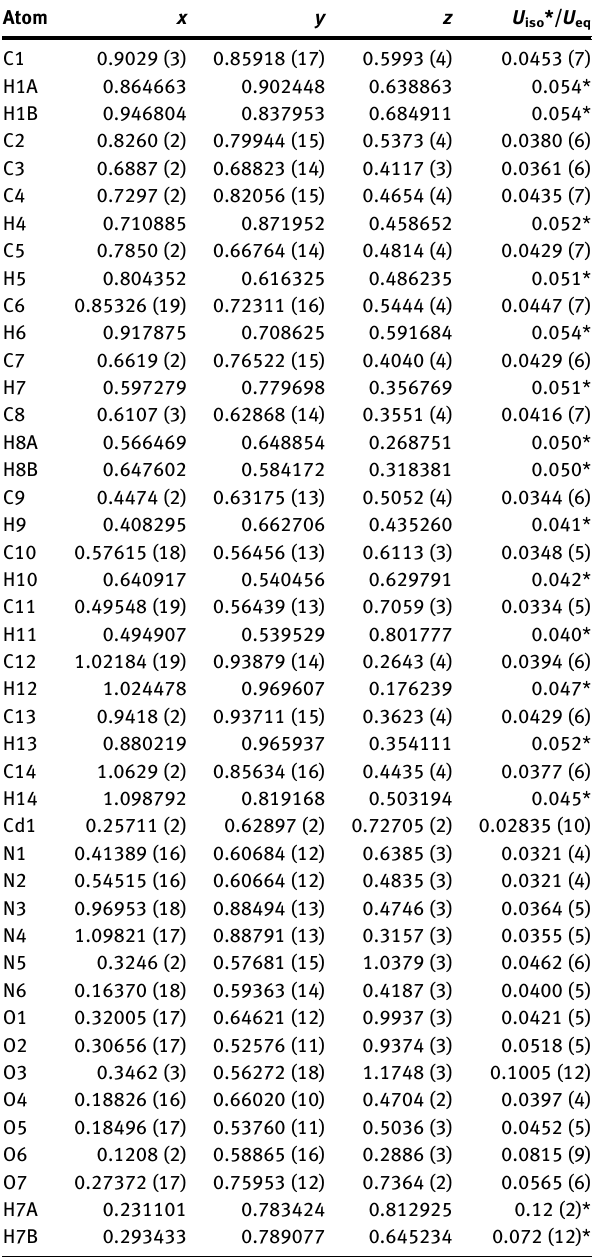
Table  : Fractional atomic coordinates and isotropic or equivalent isotropic displacement parameters (Å 